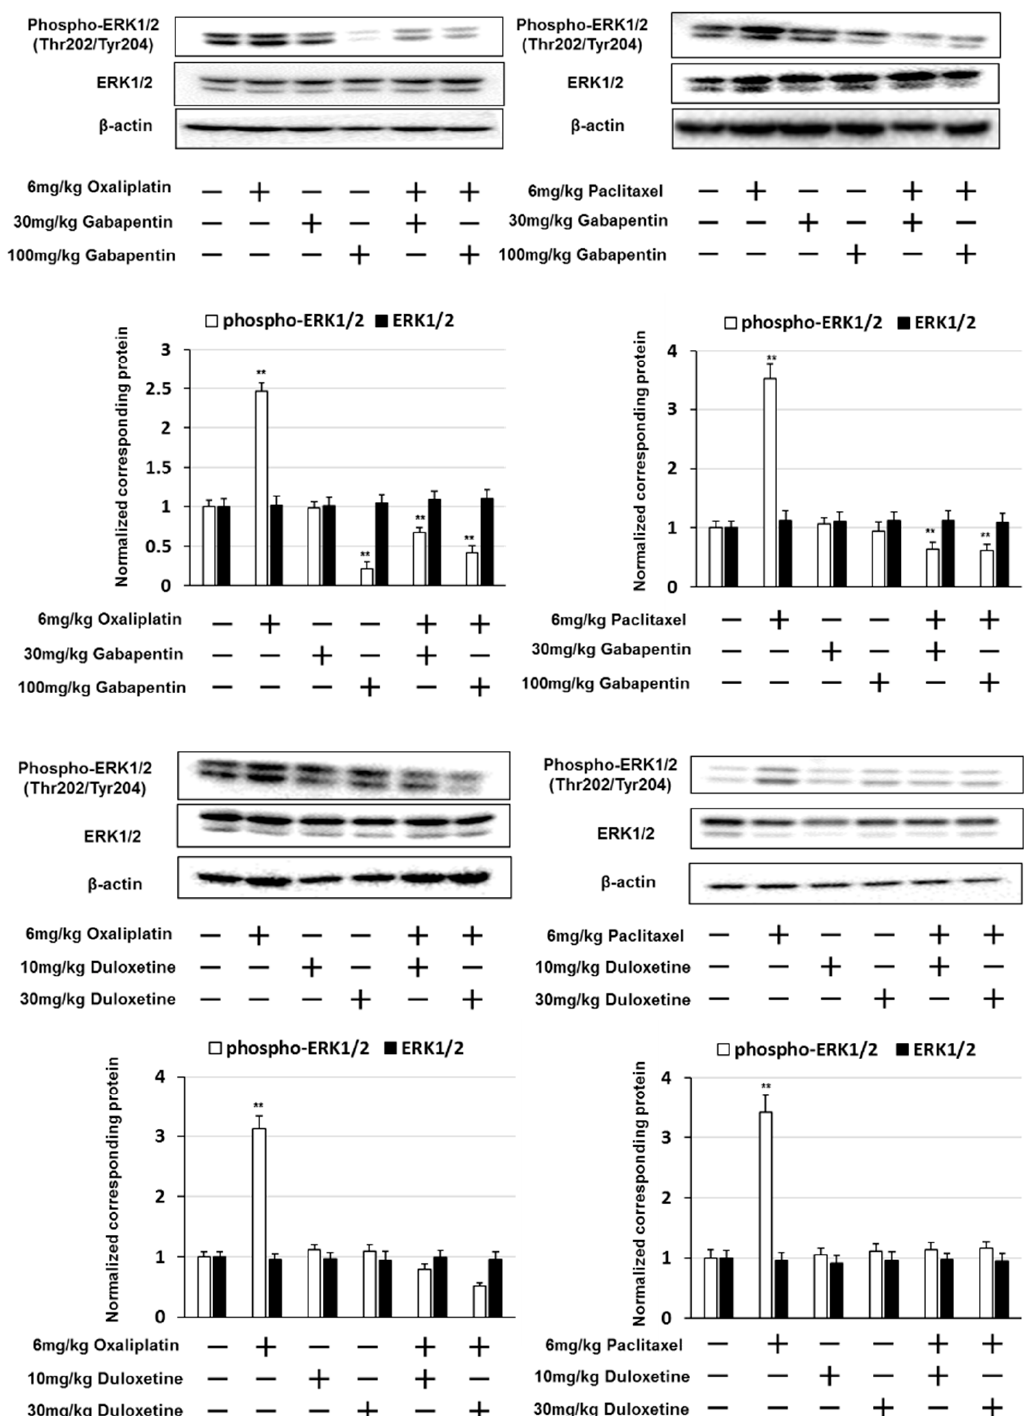
Figure 5. Gabapentin and duloxetine inhibited oxaliplatin- and paclitaxel-induced extracellular signal-regulated kinase 1/2 (ERK1/2) activation. Western blotting was conducted to analyze phosphorylated ERK1/2 (phospho-ERK1/2) protein expression in the spinal cord (L4–L6) obtained from mice on day 14 after treatment with oxaliplatin, paclitaxel, gabapentin, or duloxetine. β -actin was used as a protein loading control. Quantification of phospho-ERK1/2 and ERK1/2 expression, normalized against that of β -actin. The results show four independent experiments. ** p < 0.01 vs. controls (Shapiro–Wilk test and ANOVA with Dunnett’s test).